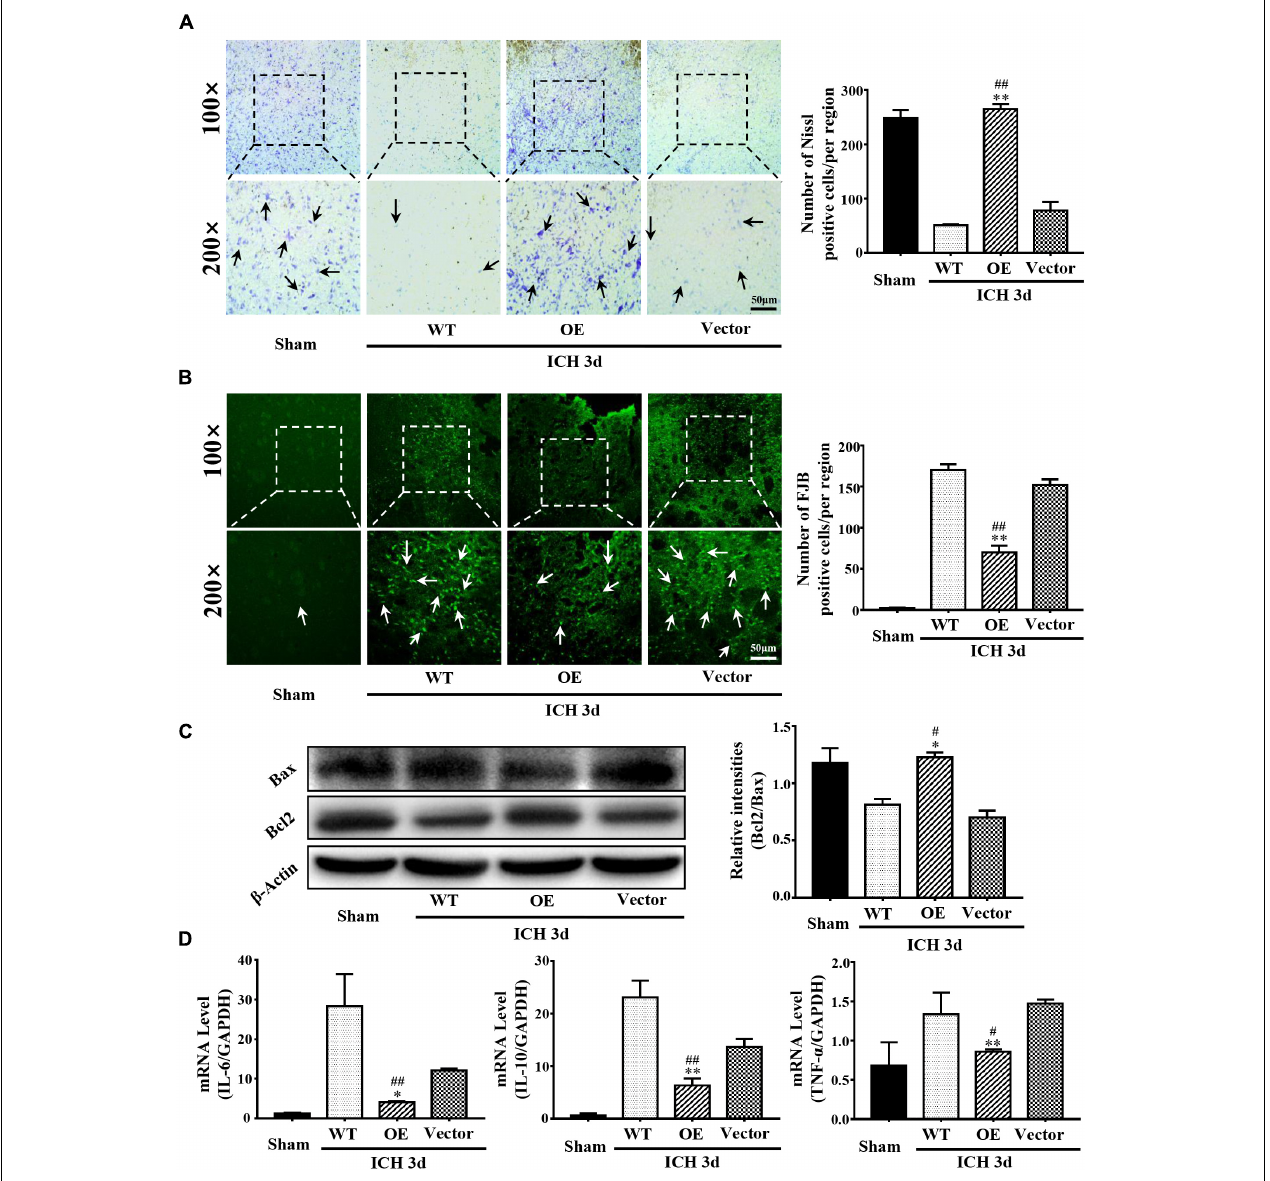
FIGURE 4 | Prdx1 overexpression inhibited inflammation and apoptosis after ICH. (A) Representative Nissl staining in sham, WT, Prdx1-OE and Vector rats. The number of Nissl-positive cells was assessed (scale bars, 50 µ m, df = 3, F = 174.206, ∗∗ P < 0.01 versus Vector; ## P < 0.01 versus WT, n = 3). (B) Representative FJB staining in sham, WT, Prdx1-OE, and Vector rats. The number of FJB-positive cells was assessed (scale bars, 50 µ m, df = 3, F = 435.050, ∗∗ P < 0.01 versus Vector; ## P < 0.01 versus WT, n = 3). (C) Western blotting was used to detect Bcl2 and Bax expression in the four groups (df = 3, F = 32.759, ∗ P < 0.05 versus Vector; # P < 0.05 versus WT, n = 3). (D) Comparison of the expression of inflammatory factors in the four groups using qRT-PCR: IL-6 (df = 3, F = 27.046, ∗ P < 0.05 versus Vector; ## P < 0.01 versus WT, n = 3), IL-10 (df = 3, F = 79.041, ∗∗ P < 0.01 versus Vector, ## P < 0.01 versus WT, n = 3), TNF- α (df = 3, F = 10.274, ∗∗ P < 0.01 versus Vector; # P < 0.05 versus WT, n =